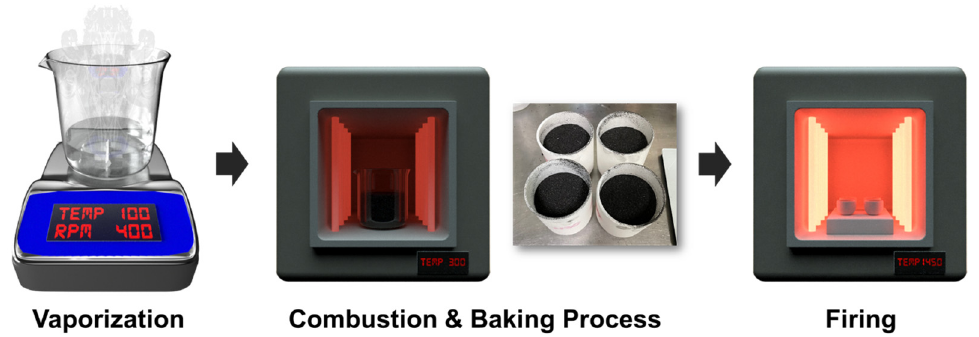
Figure 1. Schematic of the manufacturing process of nano phosphors through sol ‐ gel combustion. Ceramic phosphor was manufactured through conventional pellet ‐ forming and vac ‐ uum ‐ sintering processes. Nano LuAG:Ce 3+ phosphor and alumina powder were